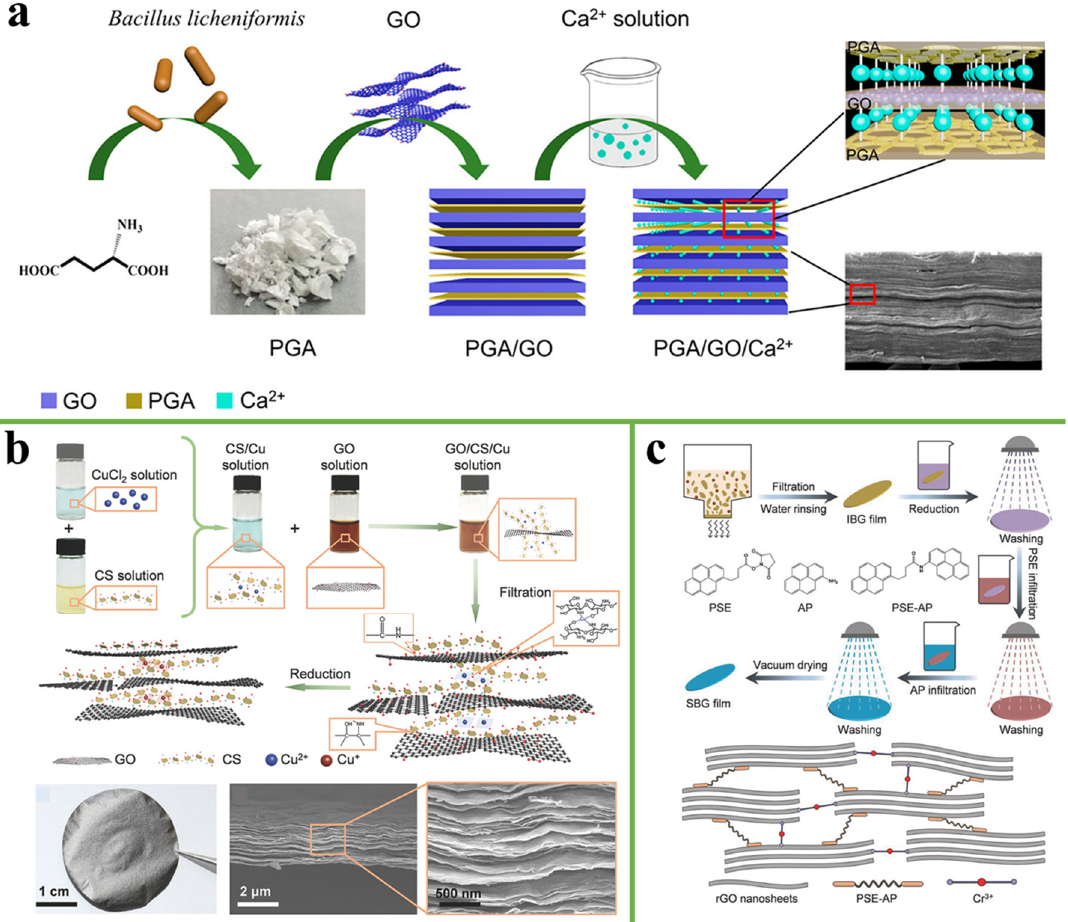
Figure 11. ( a ) Schematic illustration of the preparation process for GO/PGA/Ca 2+ composite films [92]. Reprinted with permission from ref. [92] Copyright 2020, American Chemical Society. ( b ) The illustration of the fabrication method for rGO-CS-Cu nanocomposites. Reprinted with permission from ref. [93] Copyright 2018, Wiley. ( c ) Preparation and structural characterization of SBG sheets. Reprinted with permission from ref. [97] Copyright 2018, Wiley.